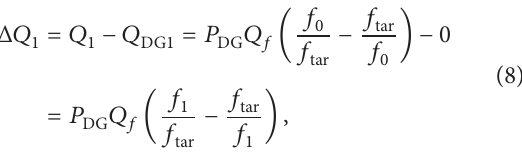
is set as 50 Hz and the tar